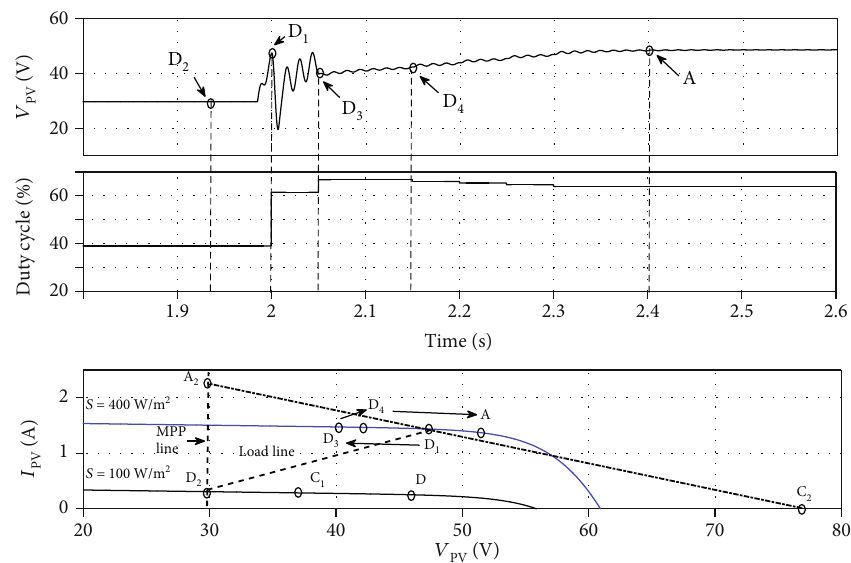
Figure 11: The process of the proposed algorithm when the irradiance is increased to 400 W/m 2